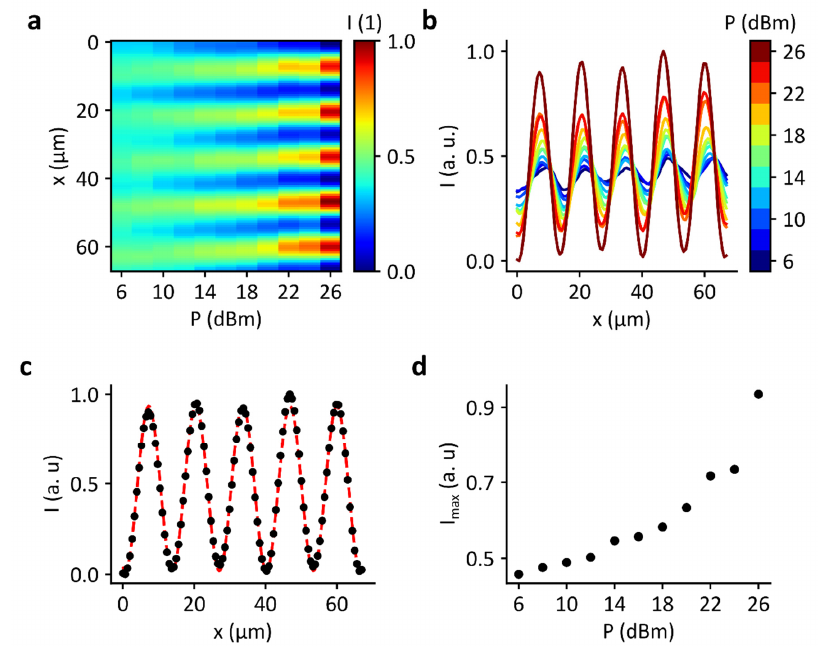
Figure 3. RF power variation of a SAW standing wave field inducing domains in a SLB: ( a ) Heatmap of the normalized brightness intensity in the power range from P IDT = 6 to 26 dBm. ( b ) Intensity profile perpendicular to the pattern of stripes. ( c ) Intensity profile for 26 dBm with a fit function (solid line) according to Equation (5). ( d ) Dependency of the intensity maximum as a function of power. With increasing power, the intensity of the pattern increases.